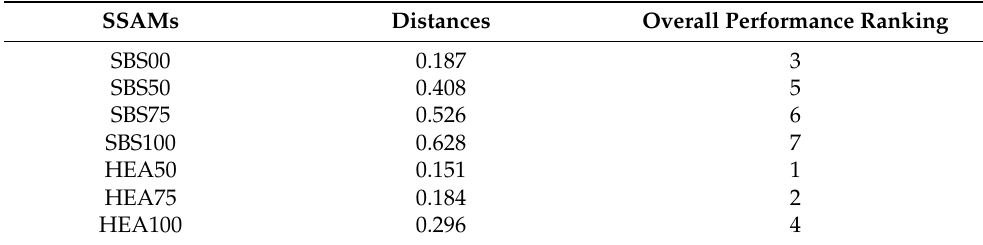
Table 10. Comprehensive performance of